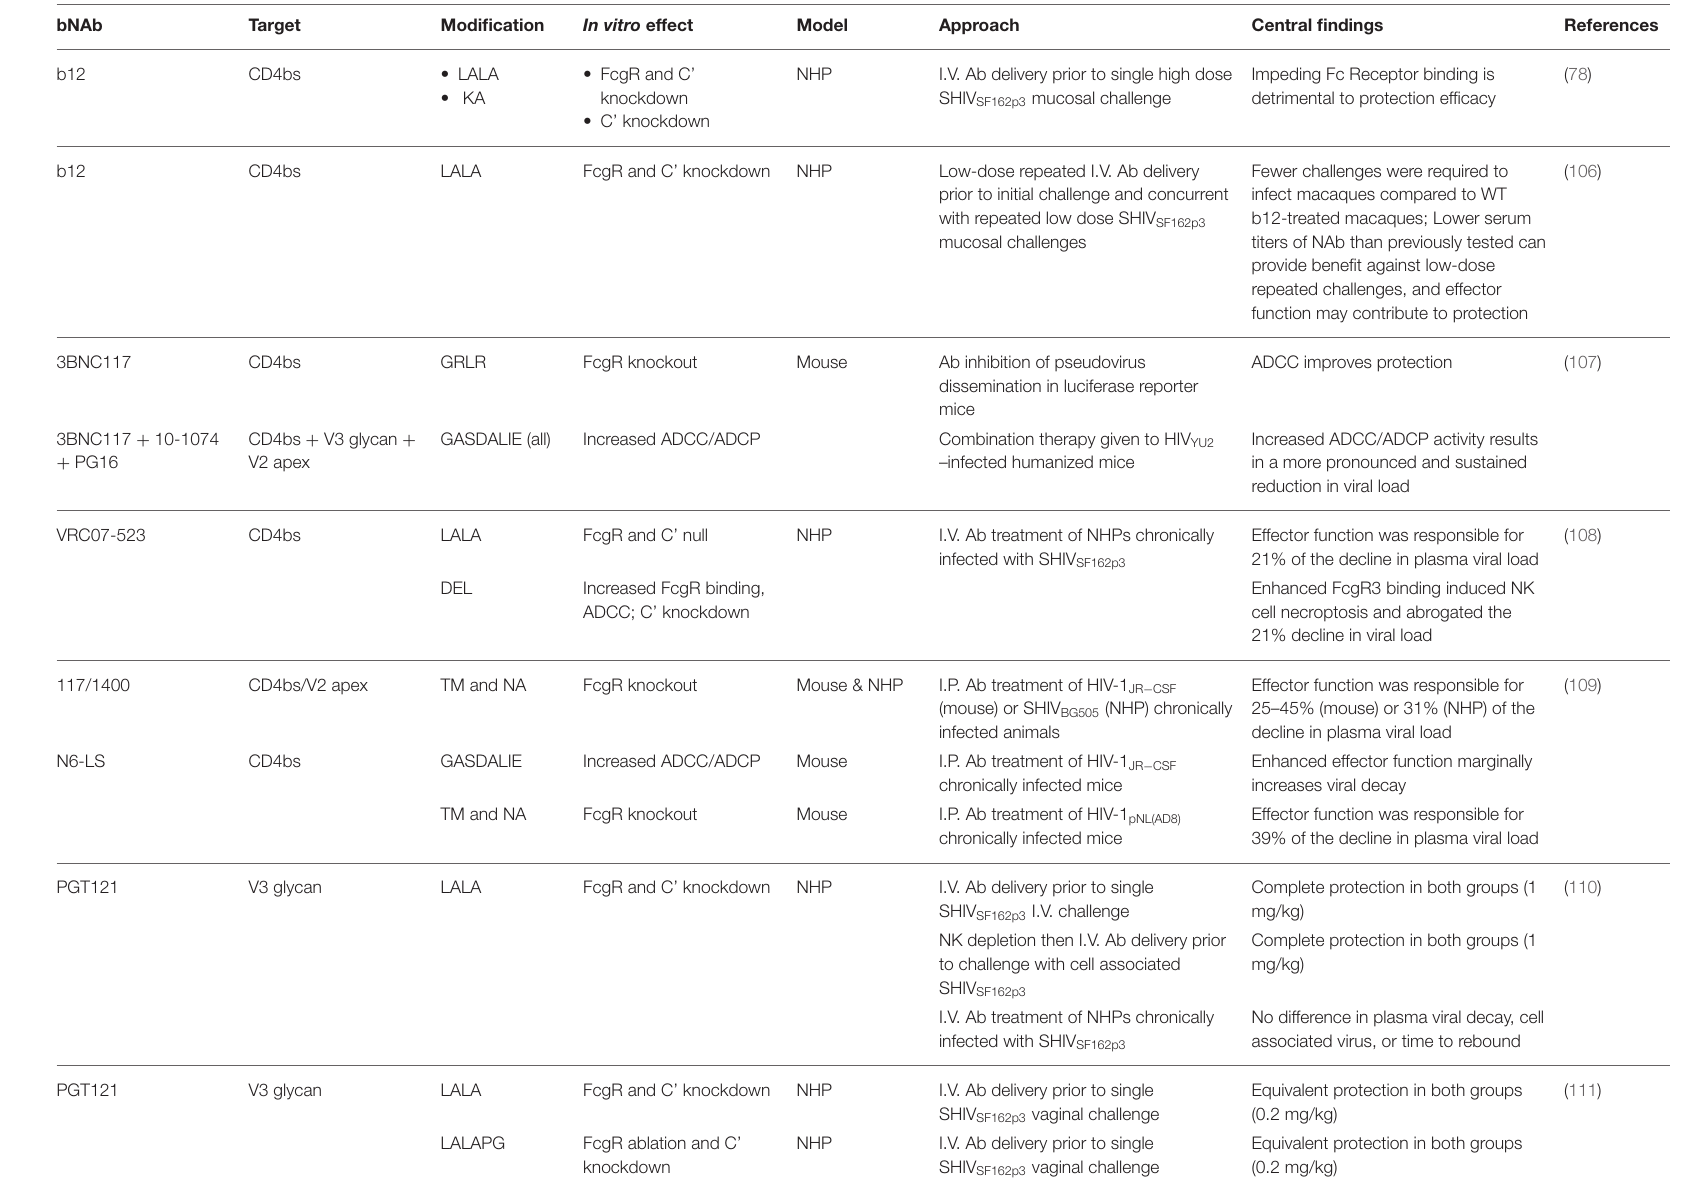
TABLE 2 | Summary of studies using HIV-1 bNAbs modified for altered Fc mediated effector functions.